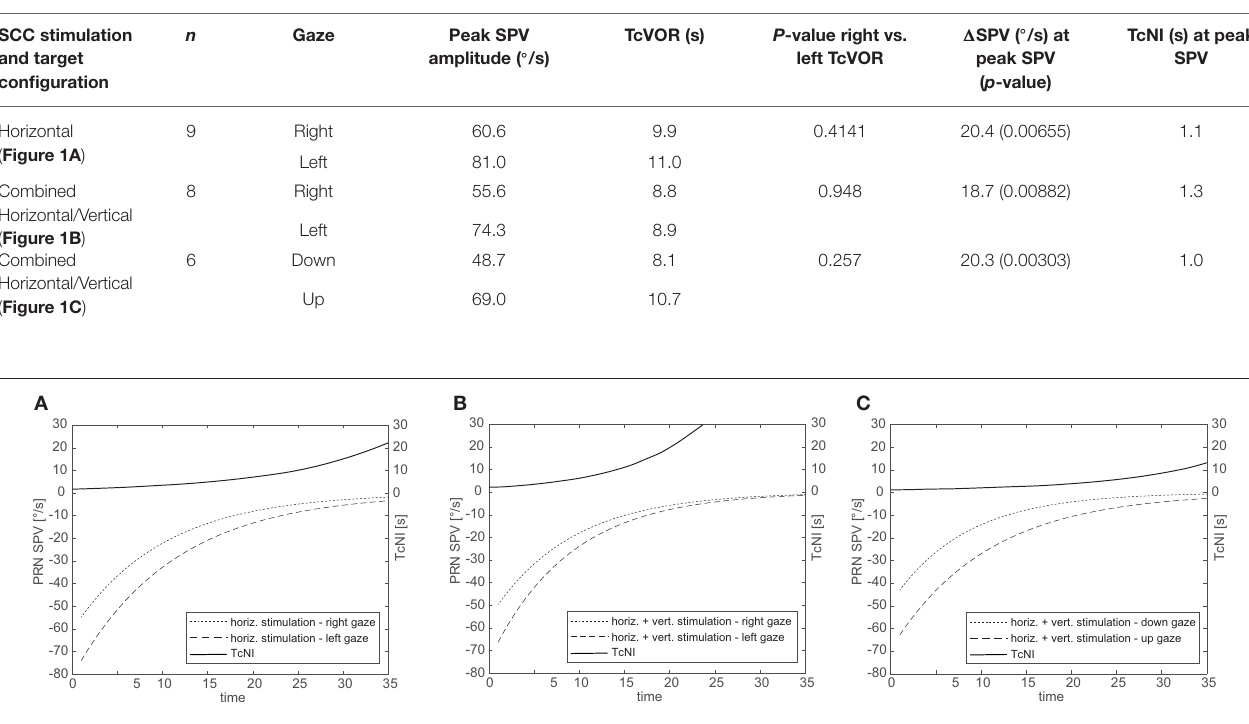
TABLE 1 | SPV, TcVOR, and TcNI for all three conditions.